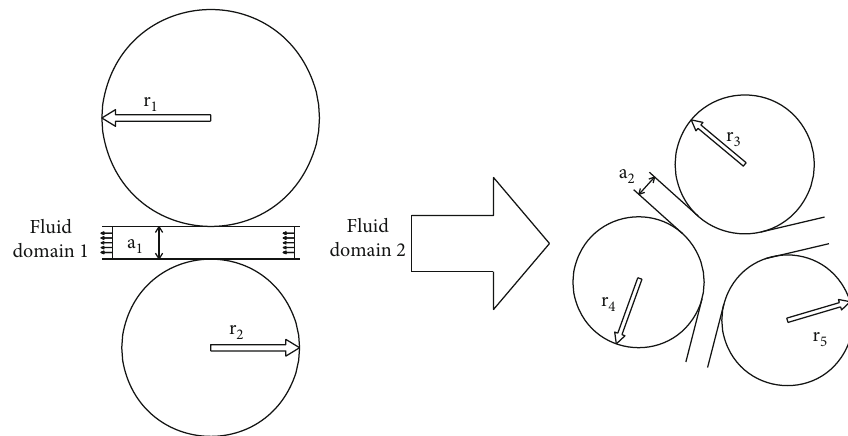
Figure 7: Seepage channel changes in broken coal and rock mass during loading and unloading processes.